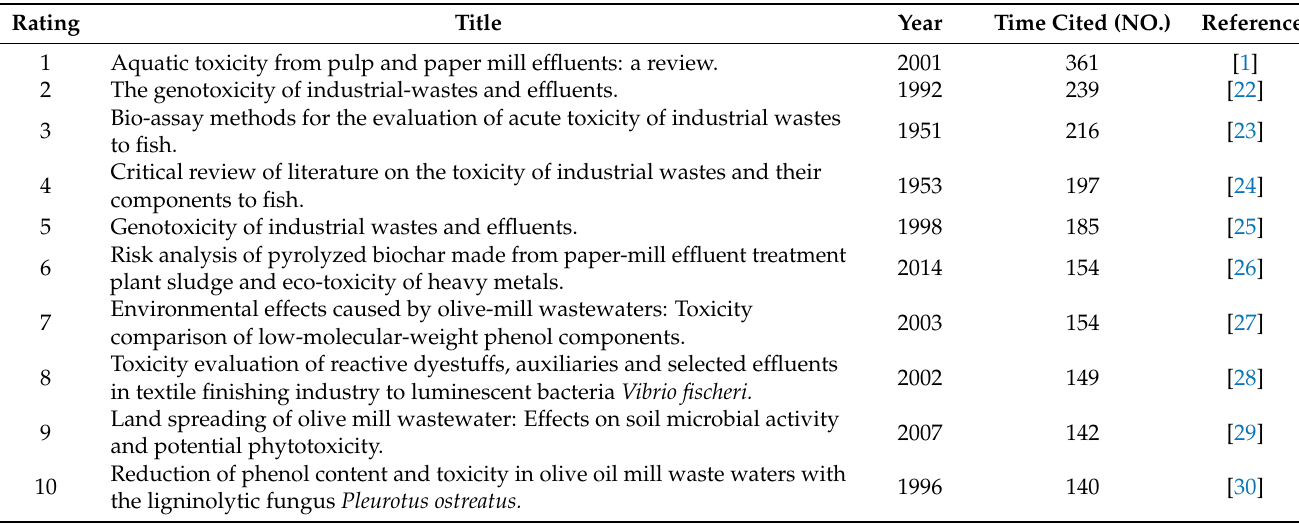
Table 8. The titles of the top 10 documents in the field of industrial effluent and sludge toxicity with the highest number of received citations according to WoS analysis.